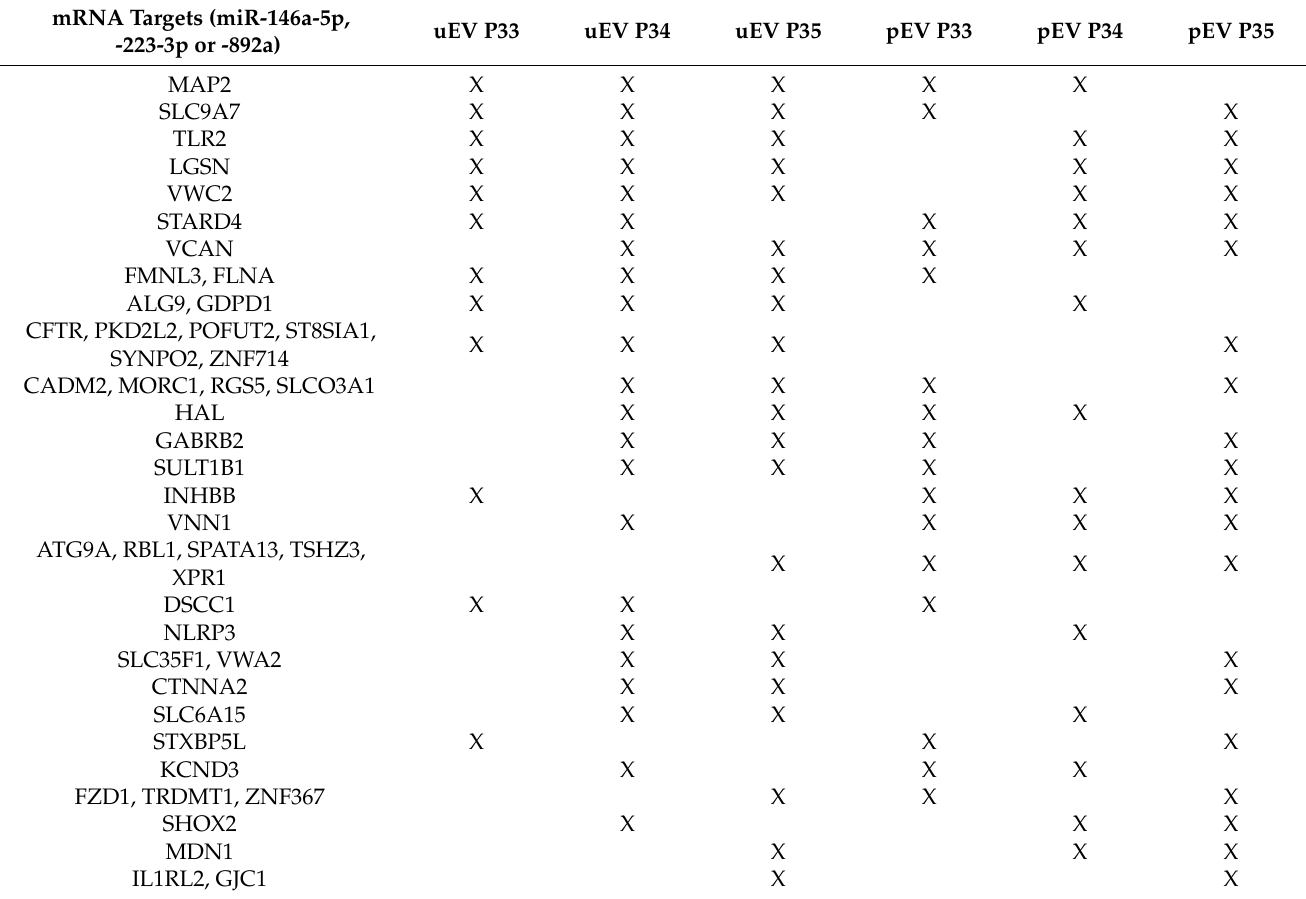
Table 5. List of mRNA targets expressed in matched uEV and pEV from the patients. Table includes 46 mRNA targets of miR-146a-5p, -223-3p or -892a that were higher expressed ( ≥ 5-fold) in the matched primary uEV and pEV samples from at least one PCa patient (P33–P35) than in the matched EV from a control (post-prostatectomy samples of P33). The higher expression per patient and EV type vs. respective control sample is marked with